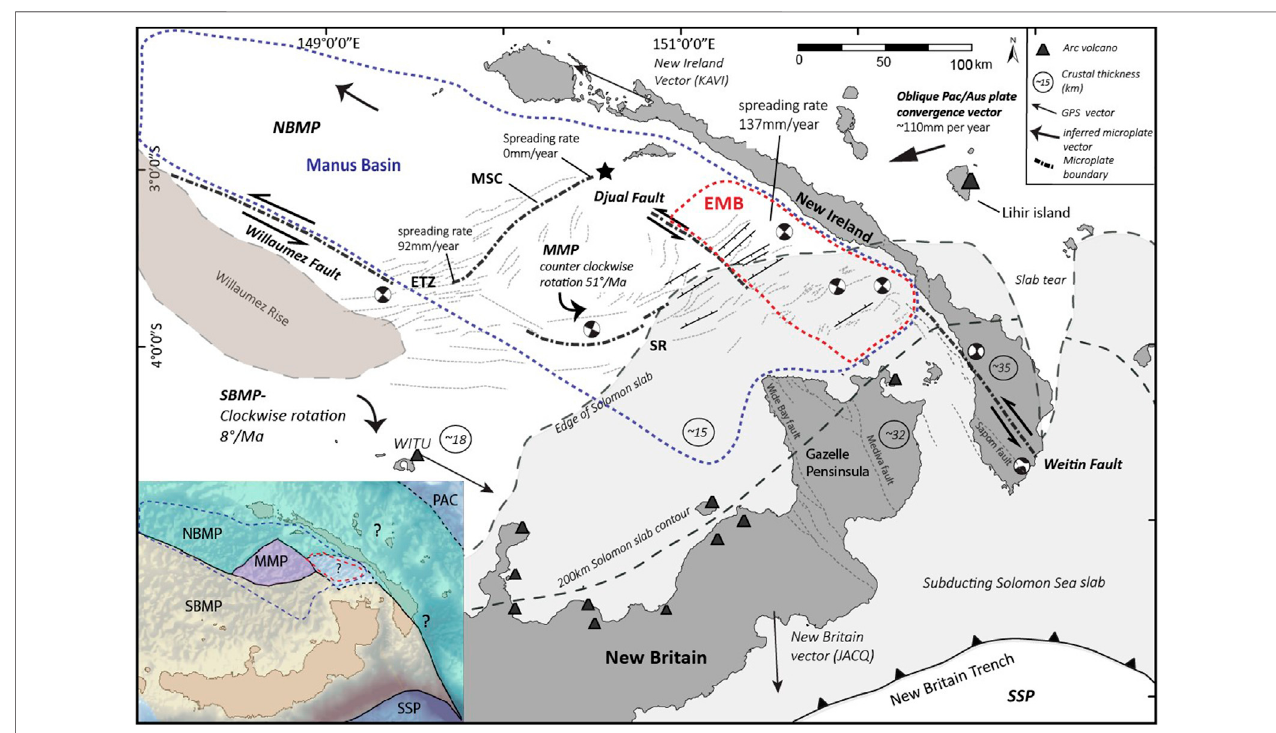
FIGURE 3 | A schematic summary of the current tectonic setting of the Manus Basin. The dashed, colored polygons highlight the extent of the Manus Basin (blue) andtheEMB(red).Thickdashedblacklinesrepresentinferredmicroplateboundaries,thatremainpoorlyconstrainedintheEMB.Abbreviations:NBMP,NorthBismarck Microplate; SBMP, South Bismarck Microplate; MMP, Manus Microplate; PAC, Paci fi c Plate; SSP, Solomon Sea Microplate; MSC, Manus Spreading Center; ETZ, ExtensionalTransferZone;SR,SouthernRifts;EMB,EastManusBasin.WITU,KAVI,andJACQareGPStrackingpoints.Blackstarindicatesthepoleofrotationfor theManus Microplate.CrustalthicknessfromFinlayson andCull(1973a)and Finlayson andCull(1973b).Focalmechanism ‘ beachballs ’ fromavailableHarvardCentroid Moment Tensor (CMT) data (after Lee and Ruellan, 2006; Thal et al., 2014). Latest moment tensor data obtained from https://www.usgs.gov/natural-hazards/ earthquake-hazards/earthquakes – accessed May 18, 2019). Major New Britain Arc volcanoes are shown as fl at-topped, black triangles. Compiled data are from Taylor (1979); Taylor et al. (1994); Martinez and Taylor (1996); Tregoning et al.(1999); Tregoning et al. (2000); Tregoning (2002); Wallace et al. (2004); Wallace et al. (2005); Lee and Ruellan (2006); Lindley (2006); Wallace et al. (2009); Holm and Richards (2013); Holm et al. (2016); Lindley (2016); Thal et al. (2016). Inset shows microplates of the Manus Basin. Solid line represents known boundary, dashed line is unknown, or interpreted boundary. Uncoloured areas within the red dashed polygon indicate the unknown microplate placement in the EMB. Question marks indicate the uncertainty of the plate boundaries in the eastern area.